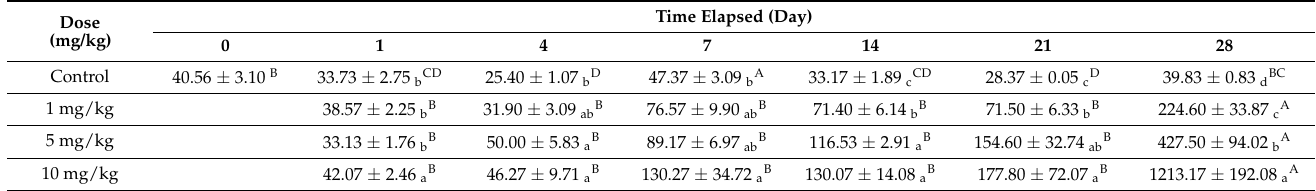
Figure 5. Superoxide anion production rate of hybrid grouper fed with various concentrations of methylmercury for 28 days. One-way ANOVA and Tukey’ test were performed to compare the differences between groups at indicated time point. Values are presented as mean ± SD ( n = 3). Significant differences ( p < 0.05) between treatment groups are indicated by different letters above the bars.